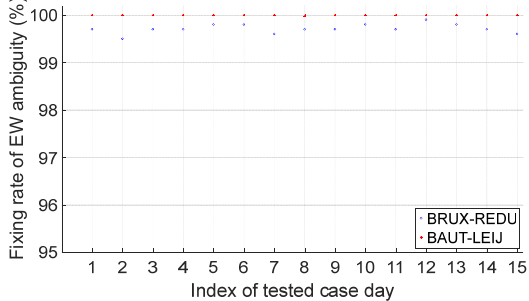
Figure 15. Fixing rate of the GPS extra-wide-lane ambiguity of